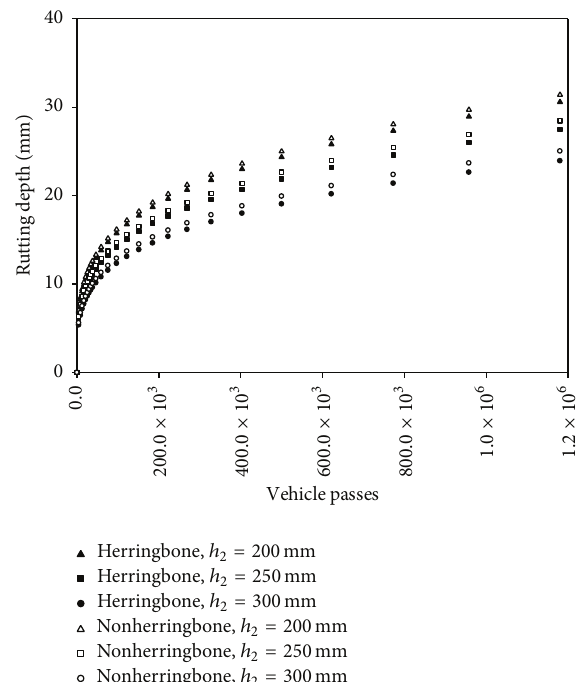
Figure 12: Difference in rut depth depending on base thickness.